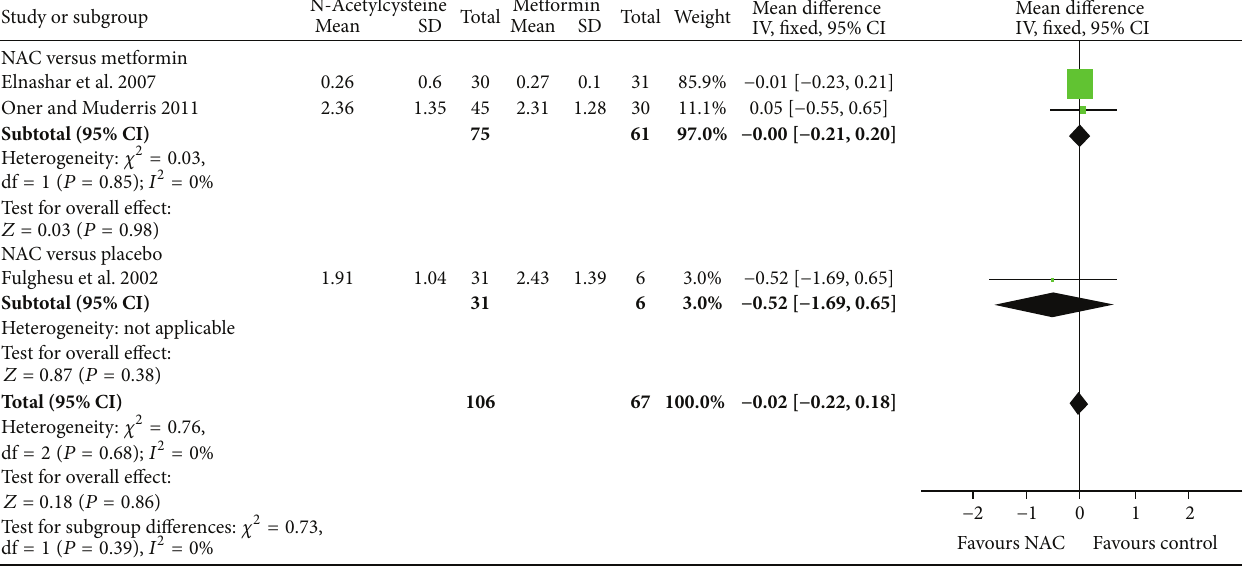
Figure 8: Forest plot: outcome: testosterone level (nmol/L) in women with PCOS comparing NAC with placebo/metformin.